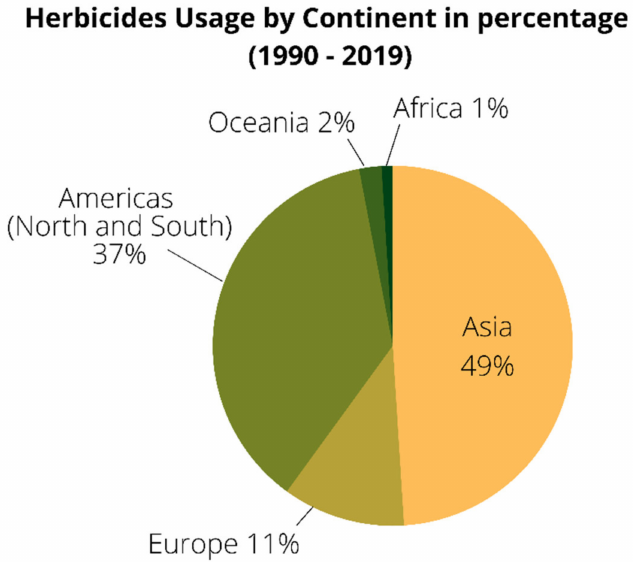
Figure 1. The herbicides usage in controlling weeds by continent from 1990 to